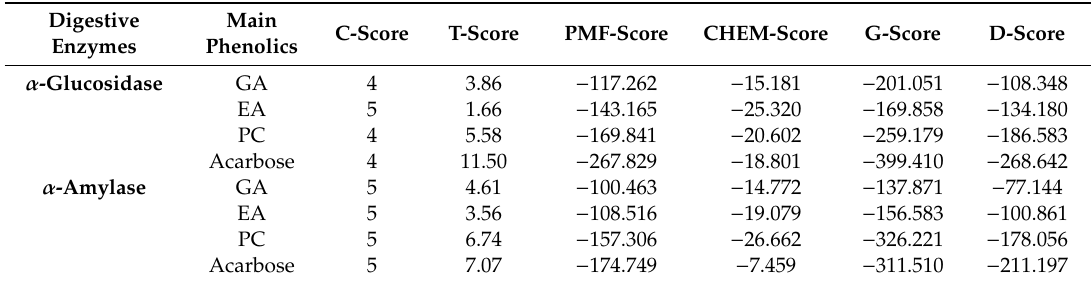
Table 3. The analysis results of the main phenolic molecules and acarbose dockings into α -glucosidase or α -amylase